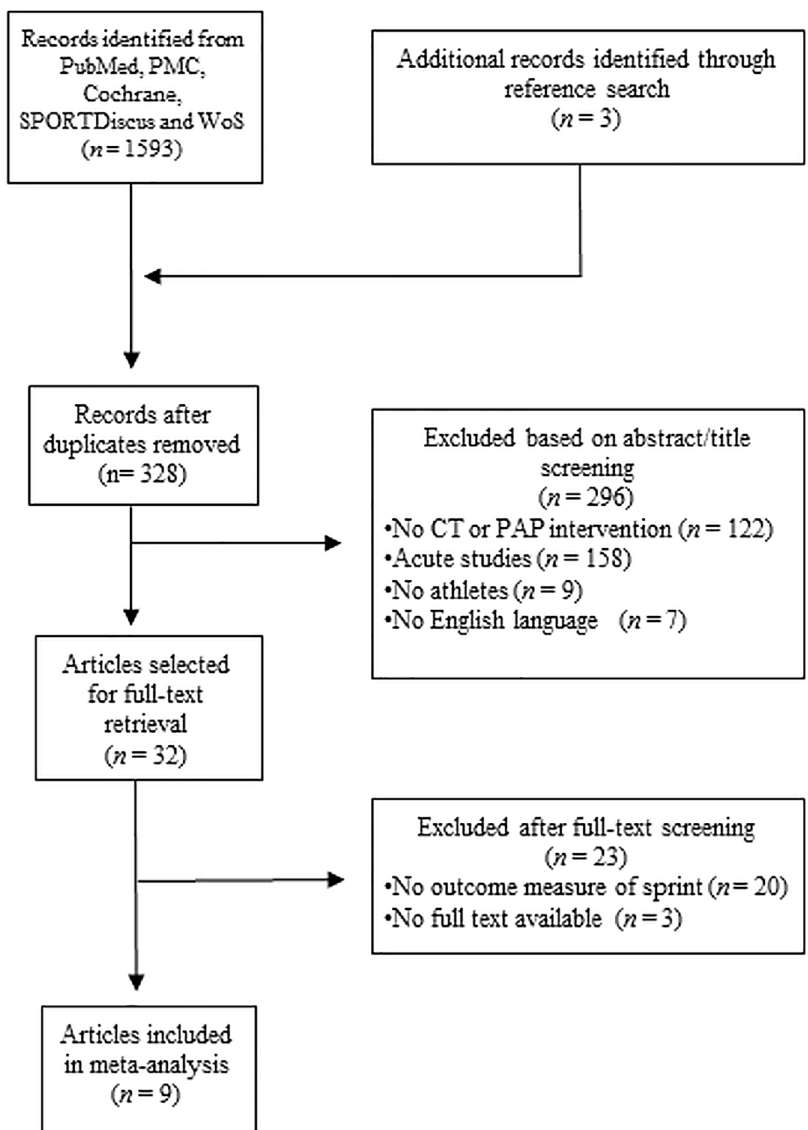
Fig 1. Flow diagram of the process of study